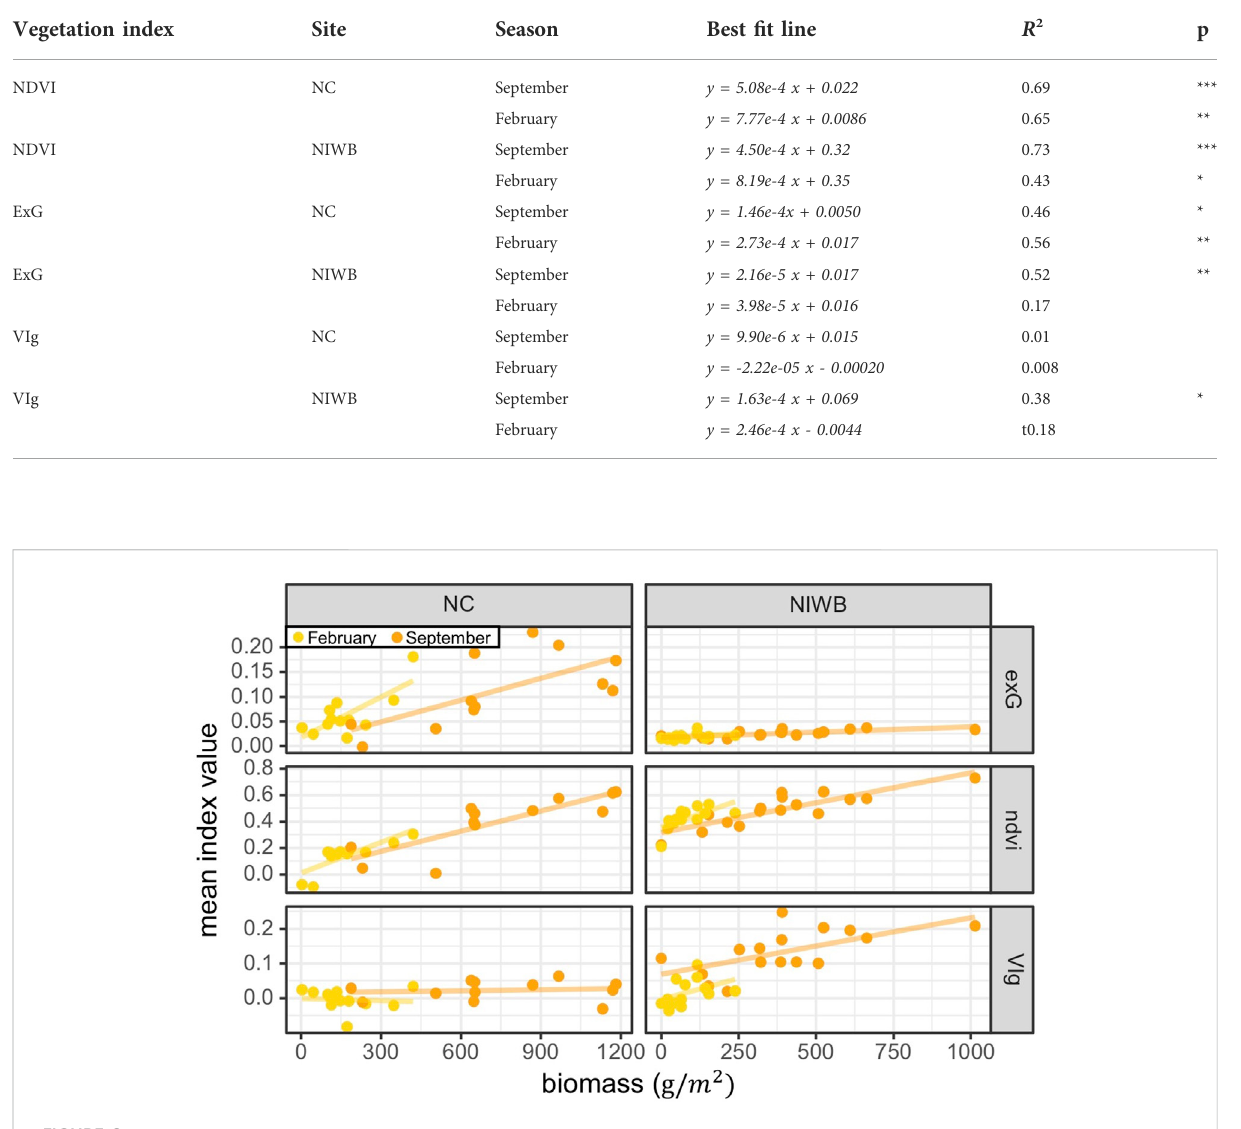
FIGURE 6 Mean vegetation index values within biomass sampling plots demonstrate varying relationships with ground-derived S. alterni fl ora above ground biomass (AGB). Excess Green (exG)and Normalized Difference Vegetation Index (NDVI) correlate well with AGB, but these relationshipsvary by season (denoted by color), and Vegetation Index Green (VIg) shows no clear relationship with